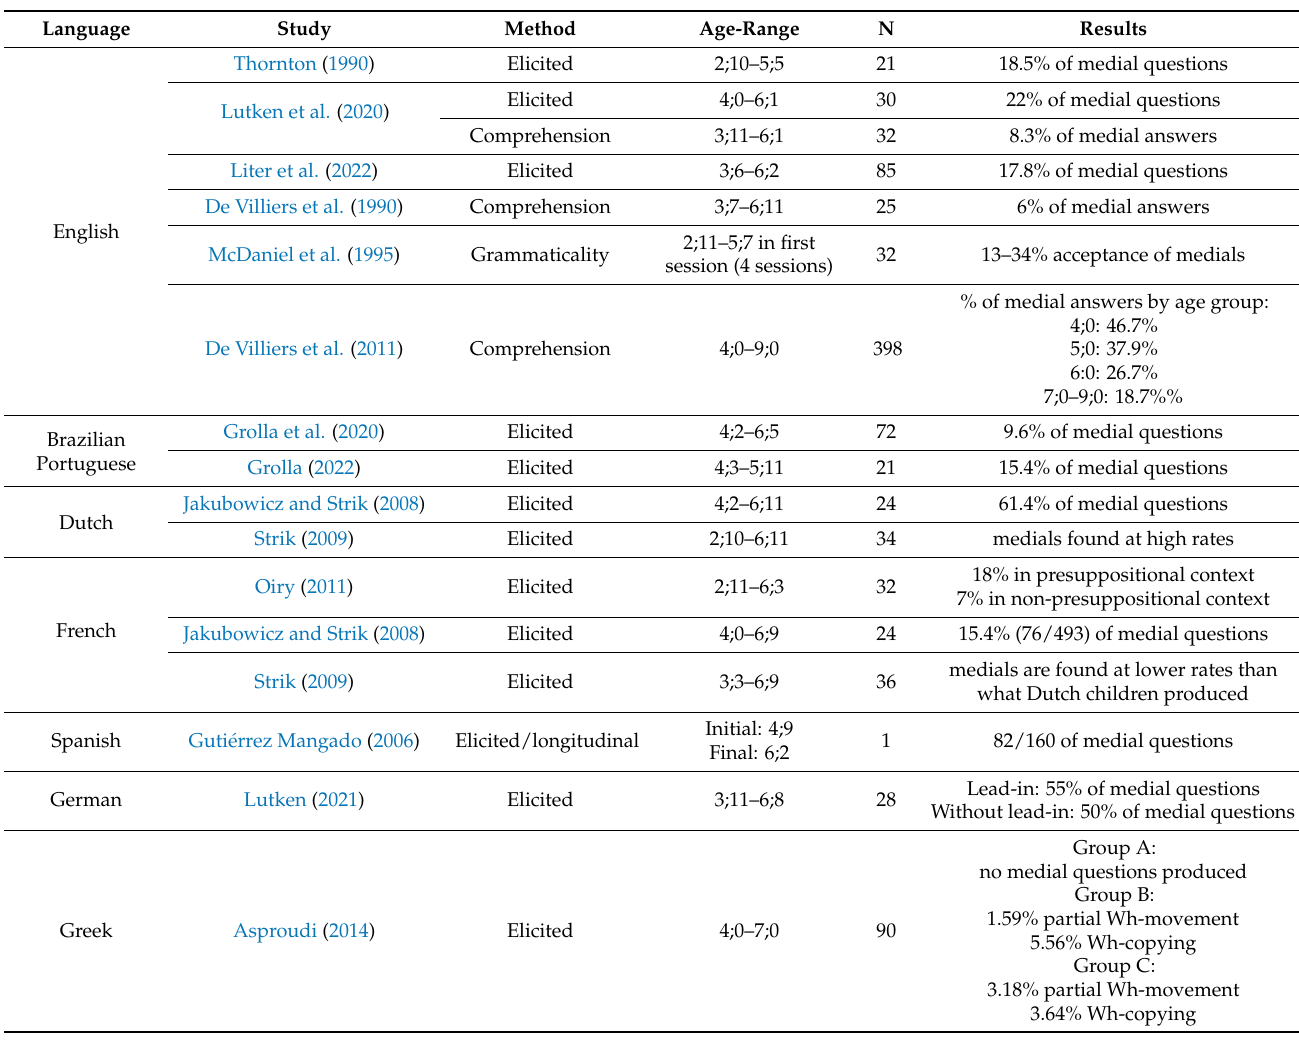
Table A2. Data on medial